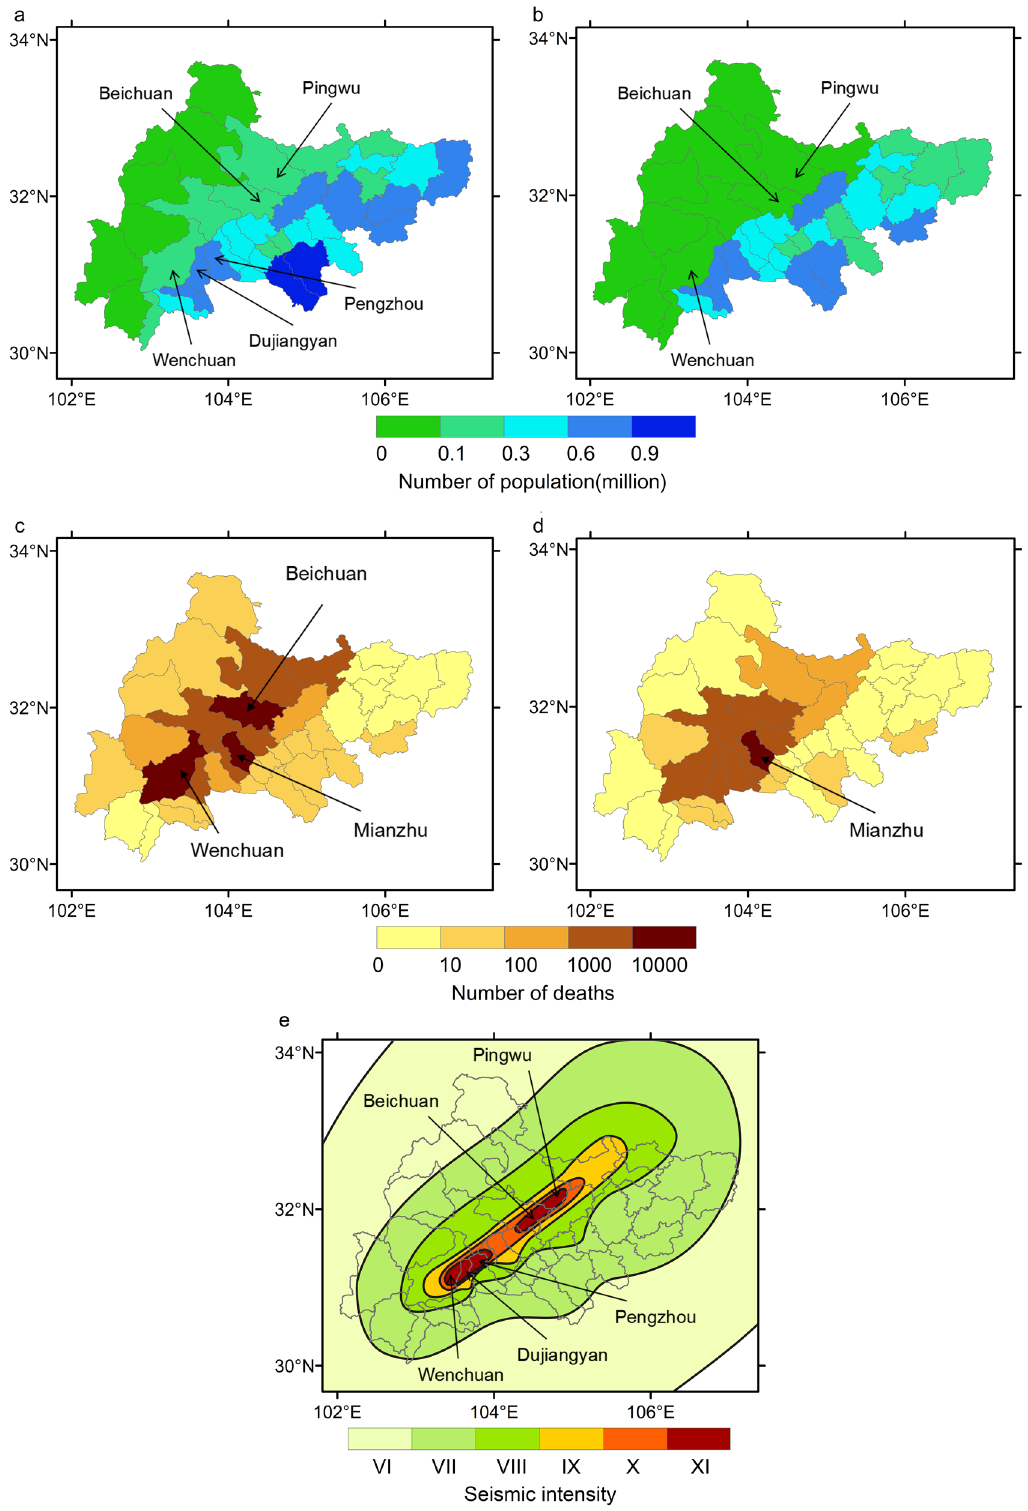
Fig. 2 Comparison of Wenchuan earthquake simulation results with actual results. a , b Population distribution during the 2008 Wenchuan earthquake. a Actual population. b Simulated population under scienti fi c planning. c , d 2008 Wenchuan earthquake death toll distribution. c Actual death toll. d Simulated death toll under scienti fi c planning. e Wenchuan earthquake seismic intensity